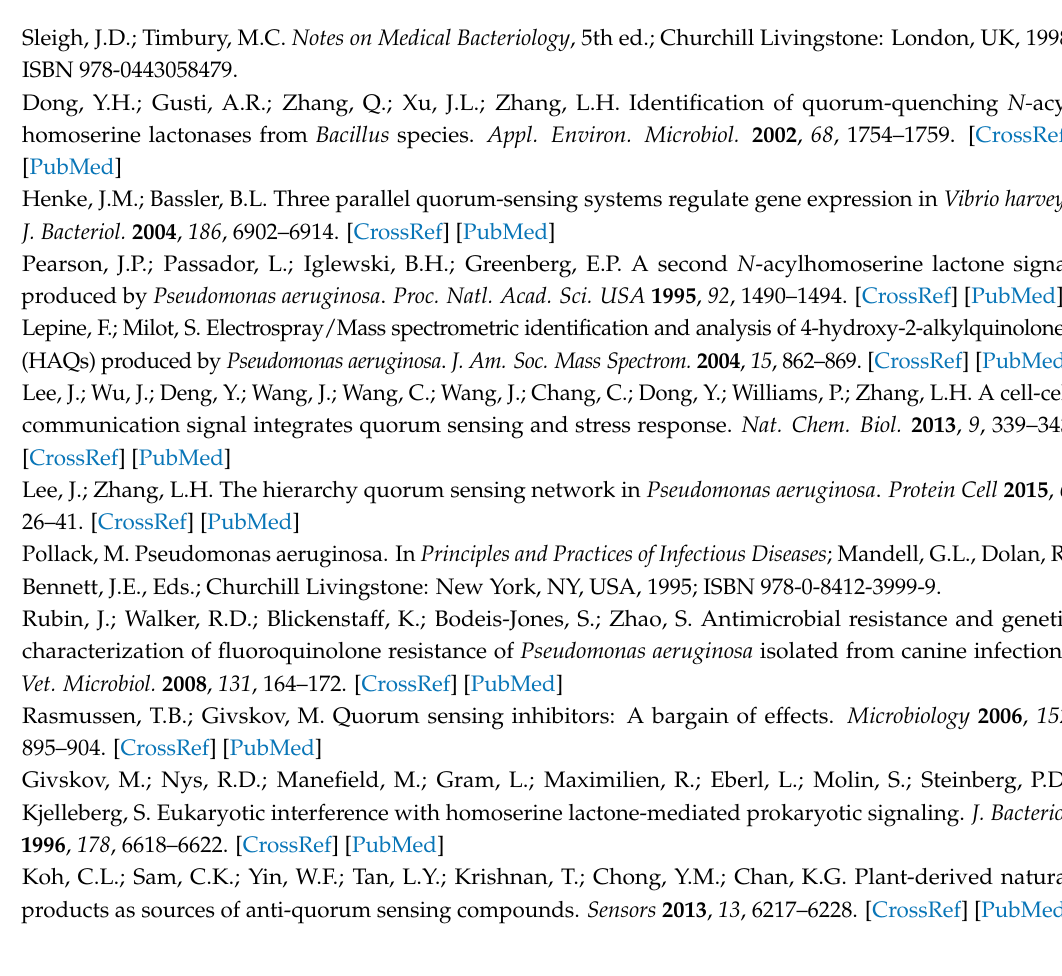
Supplementary Materials: The following are available online, Figure S1: The growth curve of C. violaceum CV026 at the concentration of 0.1, 0.5, 1, 2, 3, 4 and 5 mg/mL of plant extracts in hexane ( A ), chloroform ( B ) and methanol ( C ). Figure S2: The growth curve of E. coli [pSB401] at the concentration of 0.1, 0.5, 1, 2, 3, 4 and 5 mg/mL of plant extracts in hexane ( A ), chloroform ( B ) and methanol ( C ). Figure S3: The growth curve of E. coli [pSB1075] at the concentration of 0.1, 0.5, 1, 2, 3, 4 and 5 mg/mL of plant extracts in hexane ( A ), chloroform ( B ) and methanol ( C ). Figure S4: The growth curve of P. aeruginosa PA01 at the concentration of 0.1, 0.5, 1, 2, 3, 4 and 5 mg/mL of plant extracts in hexane ( A ), chloroform ( B ) and methanol ( C ). Figure S5: The effects of the four plant extracts ( R. pini , A. dahurica , R. cibotii and S. tenuifolia ) on the swarming motility in P. aeruginosa PAO1 at the concentration of 1 mg/mL in hexane [H], chloroform [C] and methanol [M]